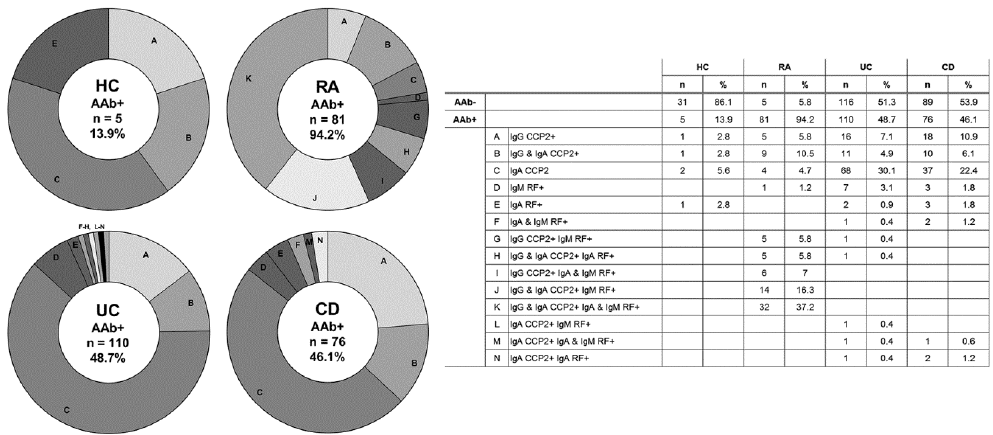
Figure 2. Distribution of arthritis autoantibody (AAb) positivity in HC (n = 5), RA (n = 81), UC (n = 110) and CD (n = 76) patients, represented in pie charts.